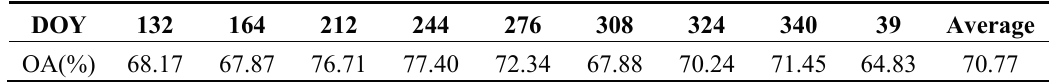
Table 5. Overall accuracies for maps obtained in process P8 by using only training samples collected in the first step. DOY